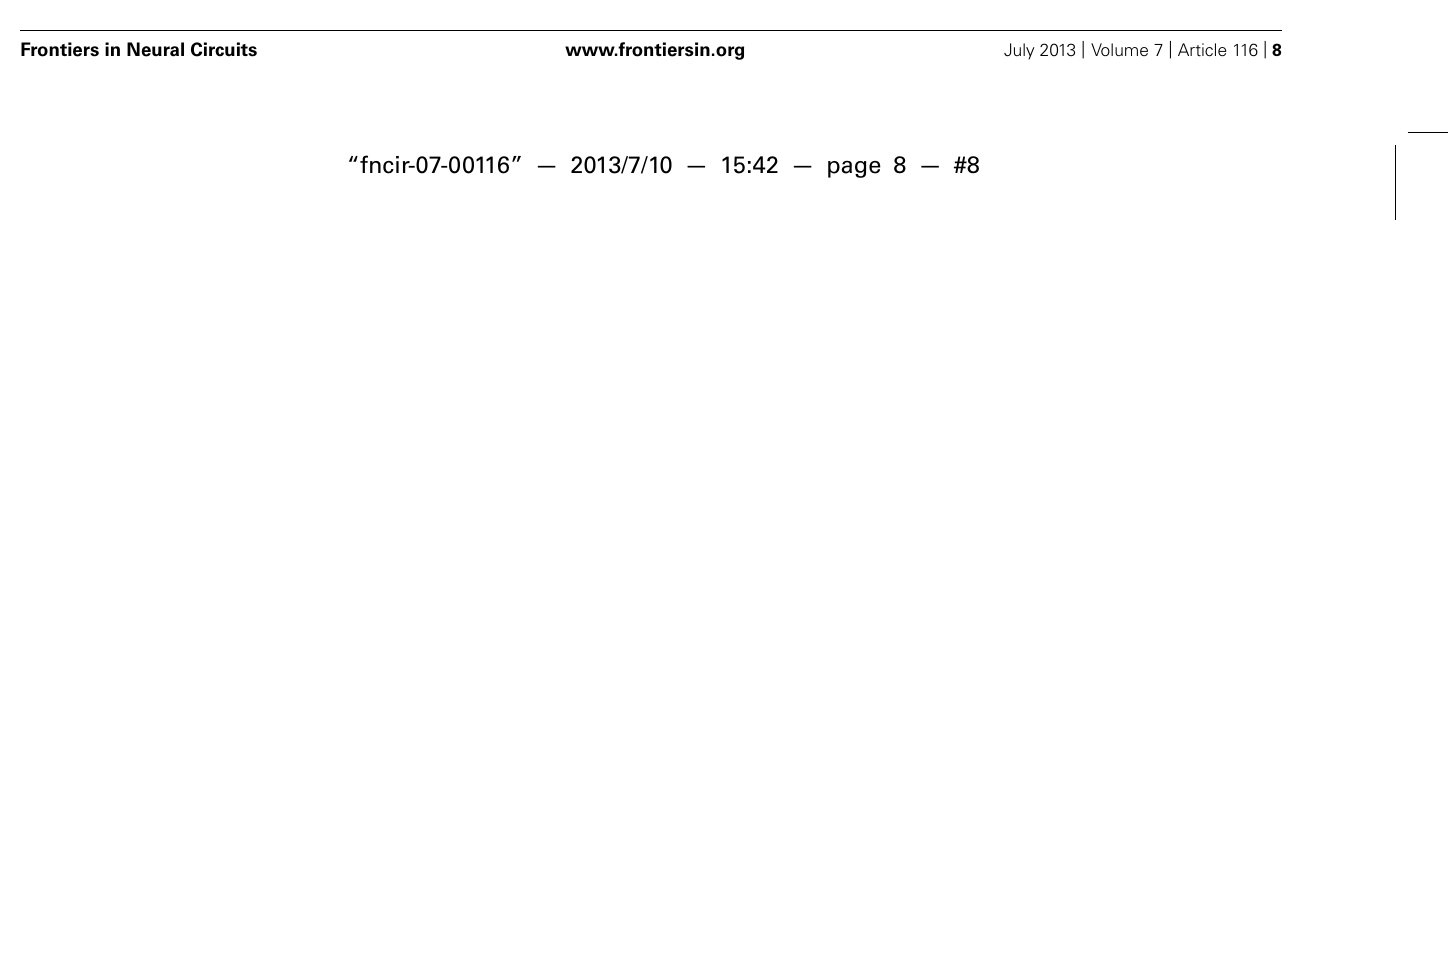
significantly higher than that of the cells that were recorded using a standard intracellular solution ( p << 0.05). Surprisingly, all